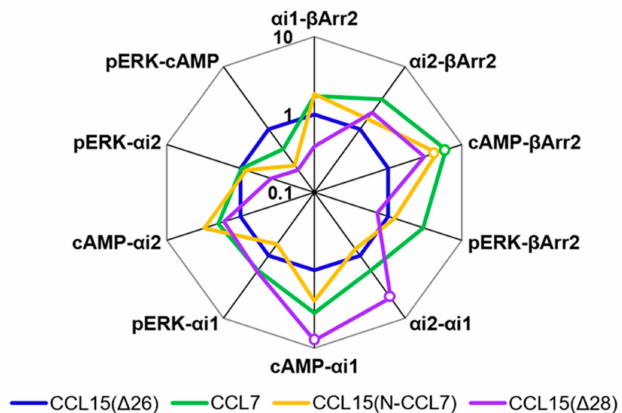
Figure 4. Web of bias for chemokine N-terminal variants at CCR1. Bias factors were calculated as described in Materials and Methods. Each axis represent the 10 ∆∆ (Log( τ / K A)) values comparing two particular pathways. Data points represent the mean of at least three independent experiments performed in duplicate. Open circles indicate significant di ff erences between values of ∆ Log( τ / K A ) for di ff erent pathways for a particular ligand, determined by two-way ANOVA with a Tukey’s multiple-comparison test ( p <